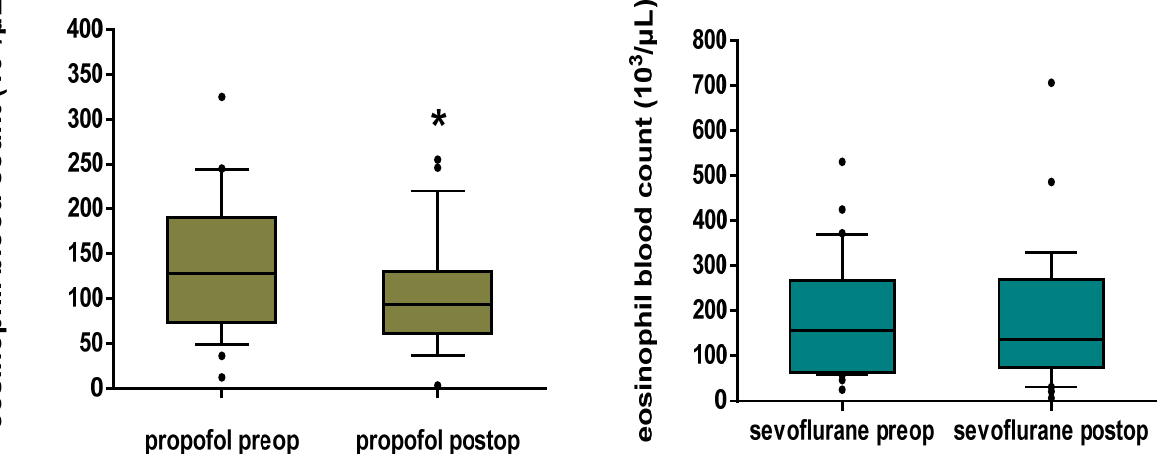
Figure 3. Box plots of eosinophil blood count in peripheral blood in the propofol and sevoflurane group preoperatively and postoperatively. Propofol maintenance caused a significant decrease in the eosinophil blood count ( p < 0.001), while sevoflurane maintenance did not have a statistically significant effect ( p = 0.746). The box plots depict the median and the interquartile range and the whiskers depict the 10th and 90th percentiles; * p < 0.05 in comparison to the preoperative status. The propofol group presented with lower standardized Ppeak and Ppl over time versus the sevoflurane group (16.6 ± 4.3 vs. 18.8 ± 3.4 cm H 2 O, p = 0.032 and 14.6 ± 4.2 vs. 16.6 ± 3.4 cm H 2 O, p = 0.054, respectively) and higher standardized compliance over time (42.4 [35.0–52.9] vs. 33.0 [30.0–41.5] mL/cm H 2 O, p = 0.027) (Table 2). Additionally, (5023.0 [3740.2.–6465.2] vs. 3743.0 [2940.2–4707.2] 10 3 / μ L, p < 0.001 for the propofol group the propofol group had lower standardized heart rate over time versus the sevoflurane group (71.6 ± 7.7 vs. 76.6 ± 8.3 bpm, p = 0.019) and higher standardized DBP and MAP over time versus the sevoflurane group (76.8 ± 8.9 vs. 68.4 ± 8.8 mmHg, p < 0.001 and 93.2 ± 10.1 vs. 86.2 ± 9.2 mmHg, p = 0.007, respectively). Finally, the propofol group had lower standardized BIS values over time versus the sevoflurane group (45.2 ± 3.8 vs. 47.2 ± 2.6, p = 0.019). No differences between the two groups for standardized values of SBP, ETCO 2 and SpO 2 were demonstrated (Table